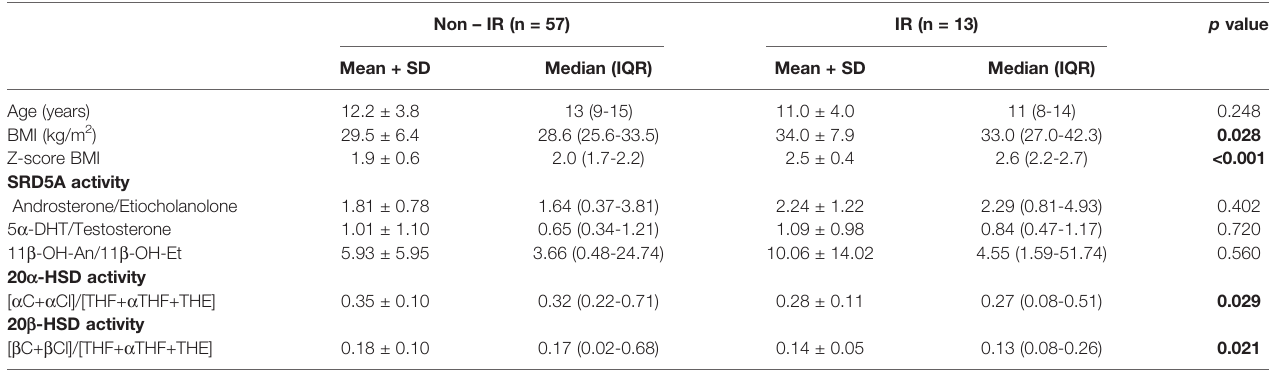
TABLE 5 | Ratios of steroid metabolites (indicative of enzyme activity): comparison between obese girls with and without insulin resistance (IR).